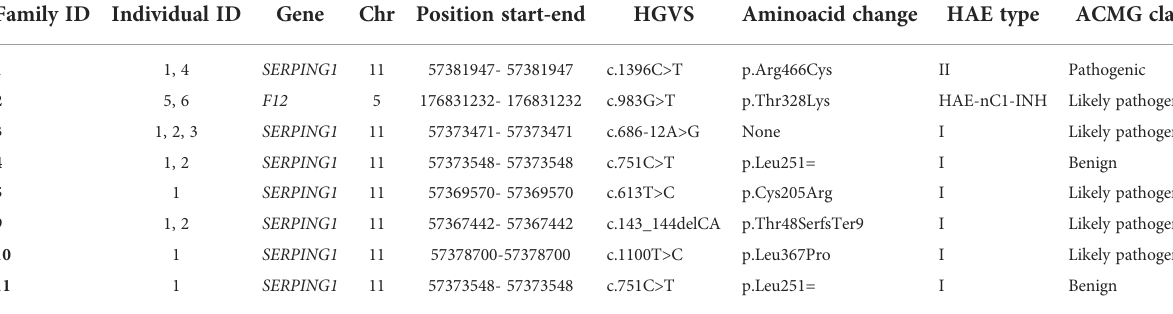
TABLE 1 Detected causal variants affecting function of HAE in this